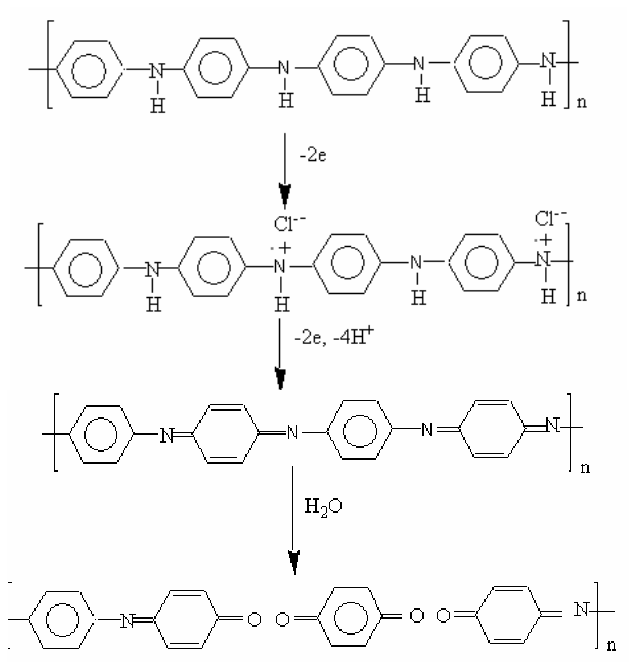
Figure 6. Redox reactions of